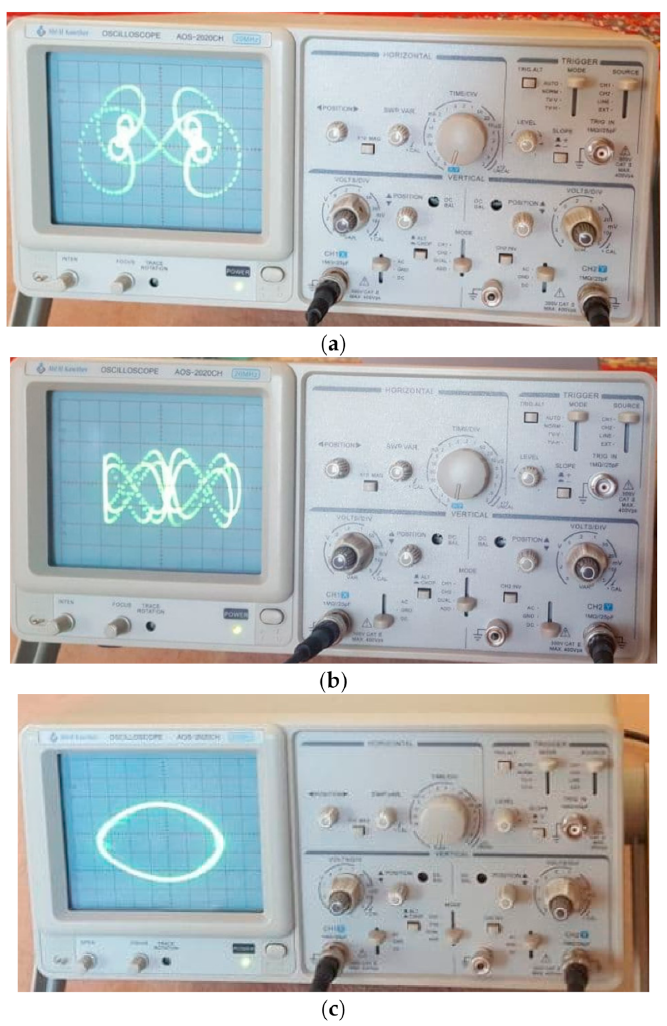
Figure 11. The experimental results of the proposed system phase portraits: ( a ) x - y chaotic attractors; ( b ) y - z chaotic attractors; ( c ) x - z chaotic